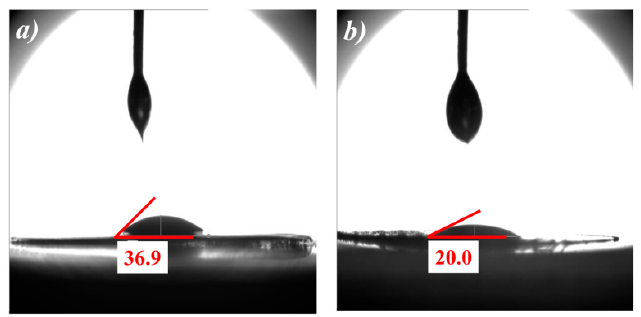
Figure 4. Contact angles of ( a ) PP and ( b ) MXene/PP separators.